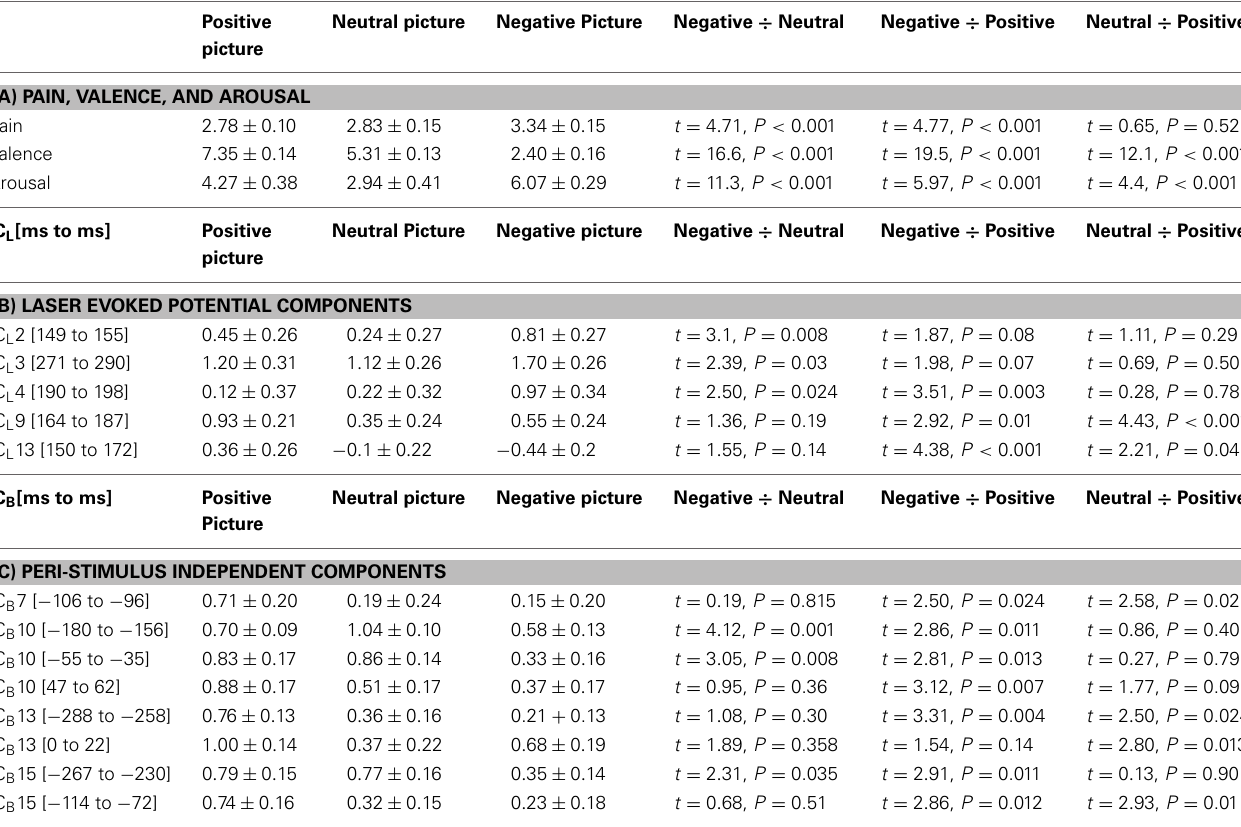
Table 1 | Effects of emotional pictures on subjective measures (A), and independent components during LEP period (B) and peri-stimulus period